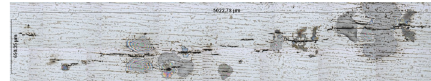
Figure4:StepwisecracksinthecrosssectionoftheAPI5LBsample exposed to solution